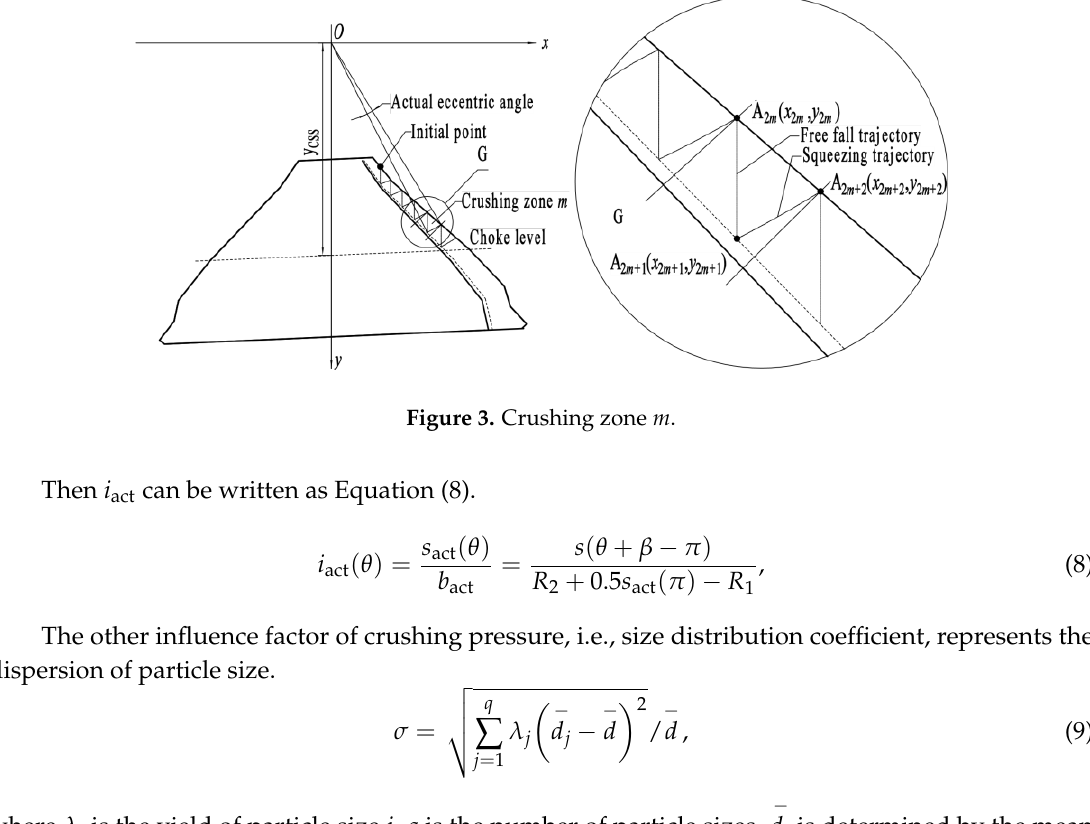
Figure 4. The flow chart of actual stroke coefficient. Then i act can be written as Equation (8). act act